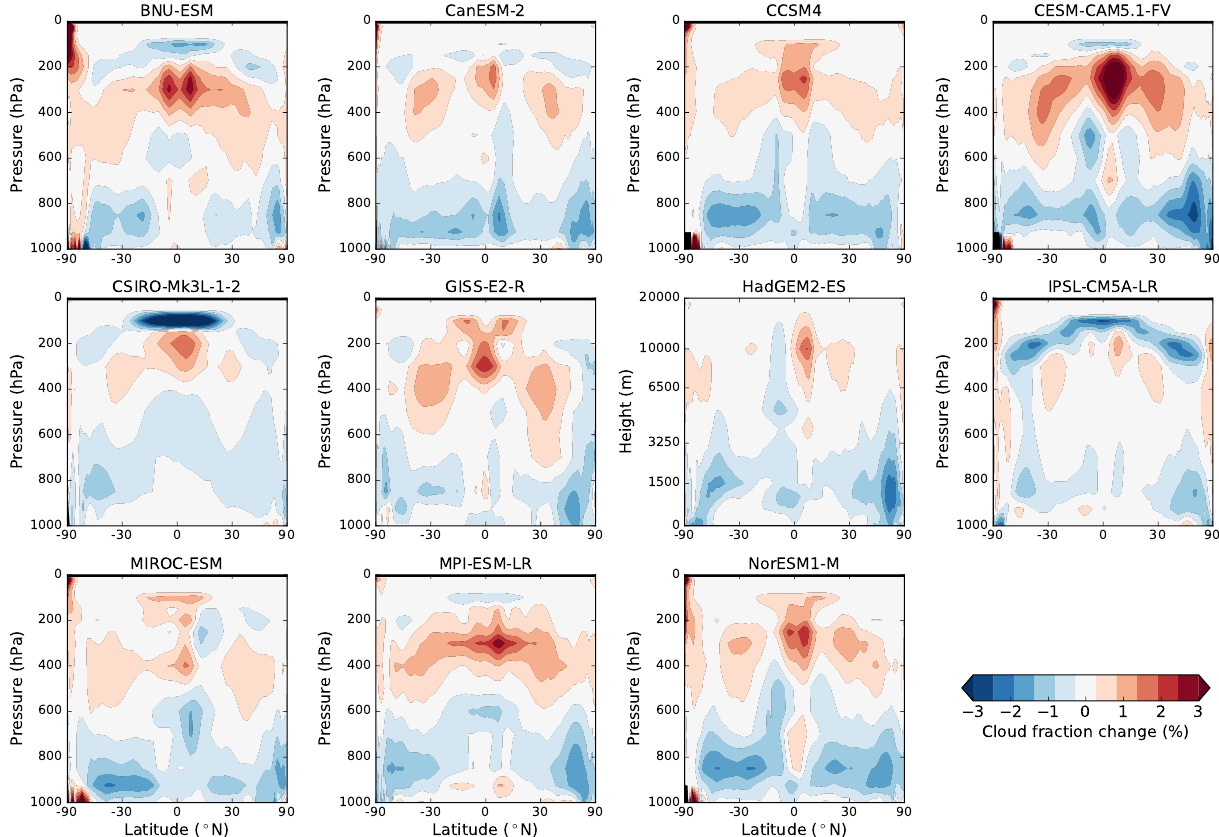
Figure 4. Zonal mean change in cloud fraction for G1 – piControl in each model as a function of pressure or height for HadGEM2-ES. To help comparisons with other models, the vertical axis for HadGEM2-ES is scaled according to e − z/ 8000m (where z is height), which is approximately proportional to pressure.